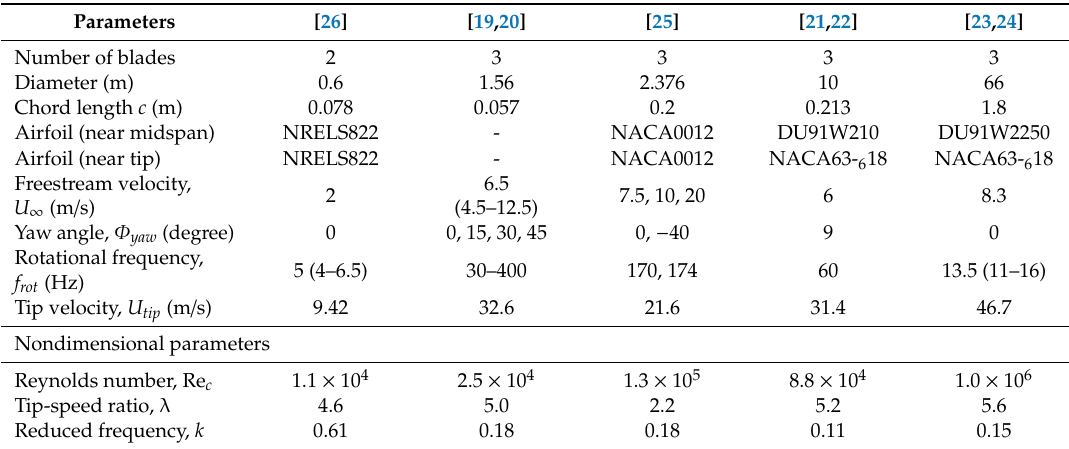
Table 1. Model and flow conditions of previous investigations on DBD-PA-based flow control for horizontal-axis wind turbines (HAWTs).